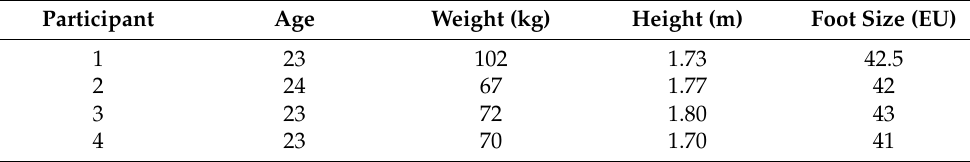
Figure 7. ( a ) Sensor location identified with MATLAB code; ( b ) foot pressure identified with markings of the ink pad. Table 1. Information of participants for the